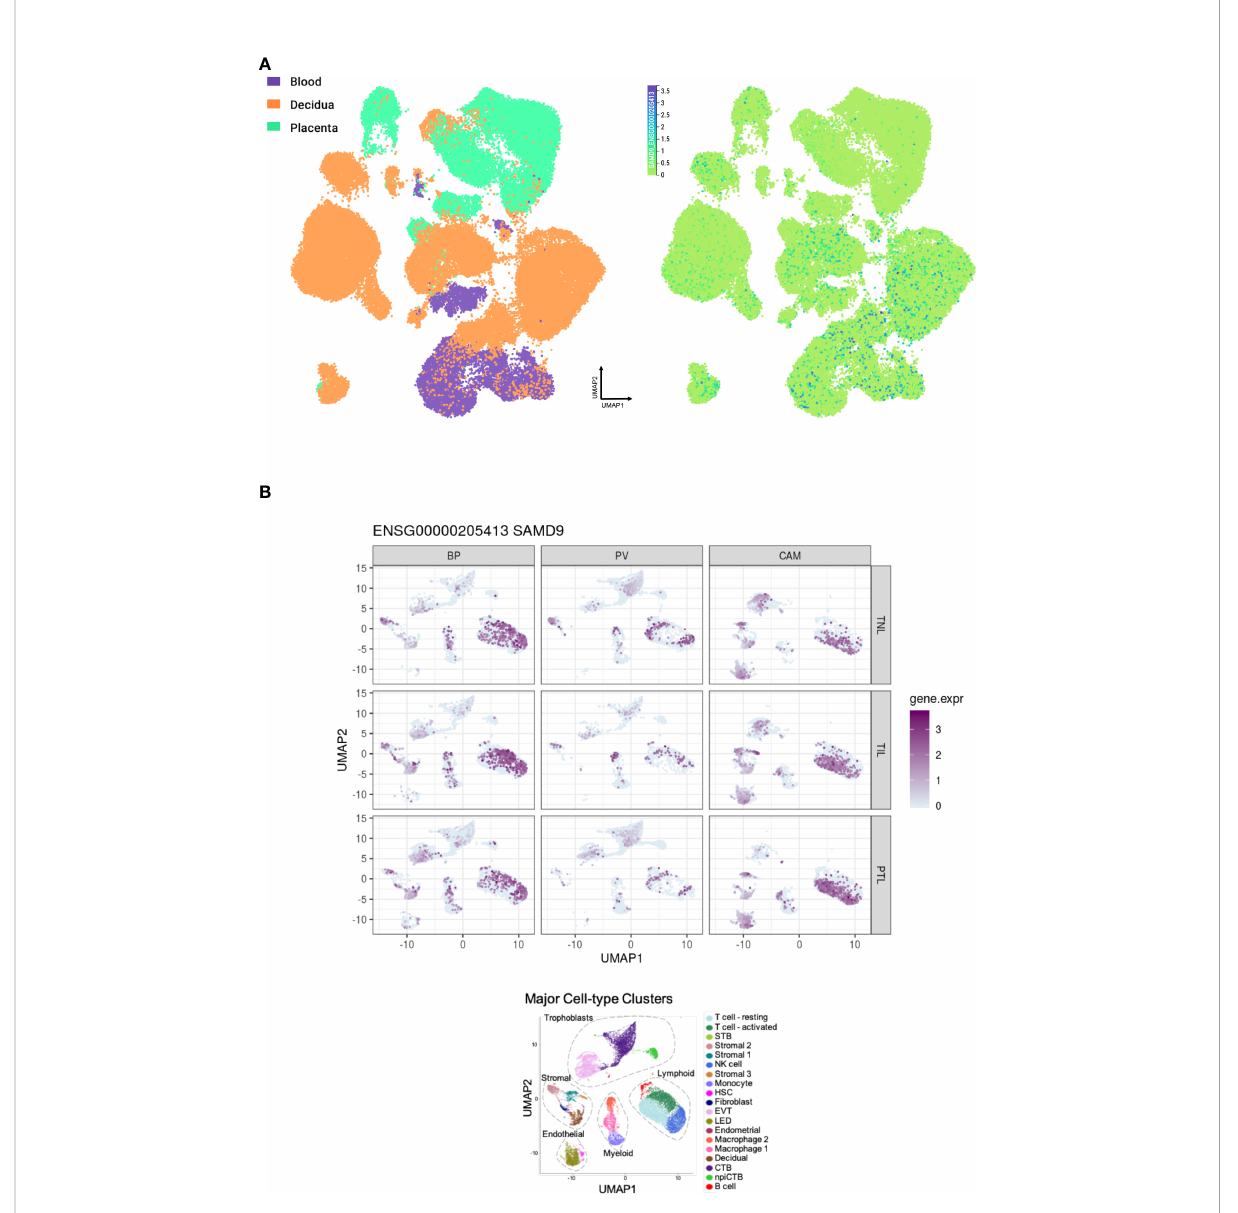
FIGURE 5 Expression of SAMD9 in human placenta. (A) Single cell RNA sequencing expression in fi rst trimester placenta shown in the left panel in orange. Data accessed from https://maternal-fetal-interface.cellgeni.sanger.ac.uk/ (49). Higher color intensity is directly proportional to high levels of gene expression. (B) Expression of SAMD9 in single cell RNA data from late trimester human placenta. Highest expression of SAMD9 is in purple. Major cell-type clusters are indicated by different colors in the bottom panel. Reproduced from Pique-Regi et al., 2019. BP, Basal Plate; PV, Placental Villi; CAM, Chorioamniotic membranes; TNL, Term No Labor; TIL, Term In Labor; PTL, Preterm Labor; UMAP, Uniform manifold approximation and projection. Data accessed from http://placenta.grid.wayne.edu/